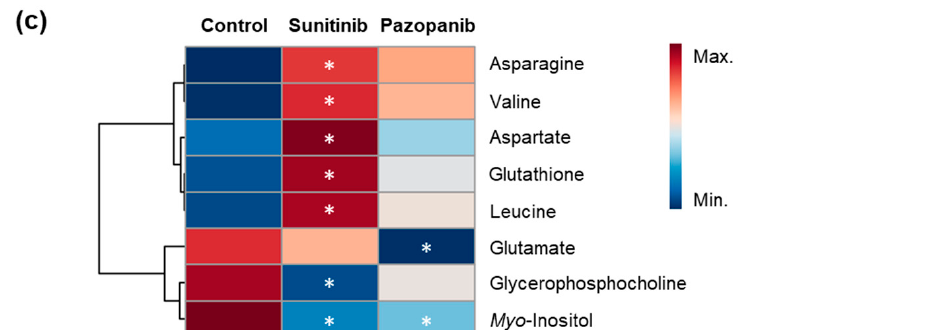
Figure 2. Impact of TKIs on the endometabolome (intracellular metabolites) profile of Caki-1 cells. ( a , b ) PLS-DA scores scatter plots (left) and loading plots (right) obtained for ( a ) non-exposed cells (green circles, n = 5) vs. cells exposed to 2 µ M sunitinib (red circles, n = 4) and ( b ) non-exposed cells (green circles, n = 5) vs. cells exposed to 50 µ M pazopanib (blue circles, n = 3). ( c ) Heatmap illustrating the mean levels of intracellular metabolites changing in Caki-1 cells after exposure with 2 µ M sunitinib and 50 µ M pazopanib. Rows correspond to the mean normalized peak area of each metabolite colored from minimum value (dark blue) to maximum value (dark red), while the columns represent each sample group. The control group represented in the first column corresponds to non- exposed cells. The statistical significance was assessed by comparison with the control cells (* p < 0.05). Abbreviations: Asp—aspartate, Glu—glutamate, GPC—glycerophosphocholine, GSH—glu-